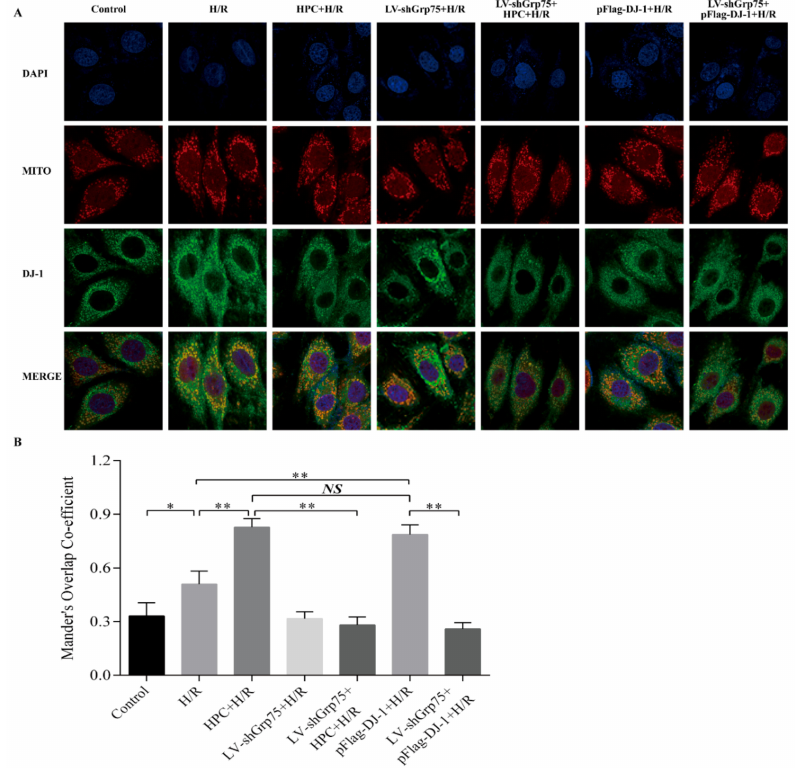
Figure 3. E ff ect of Grp75 knockdown on hypoxic preconditioning (HPC)-promoted the mitochondrial localization of DJ-1 in H9c2 cells subjected to hypoxia / reoxygenation (H / R). H9c2 cells were infected by lentiviral (LV) vectors LV-shGrp75 for 72 h and then subjected to HPC 24 h prior to H / R, or transfected with pFlag-DJ-1 for 48 h followed by H / R. Subsequently, the mitochondrial localization of DJ-1 was detected by immunofluorescence using an anti-DJ-1 antibody (Green), mitochondrial staining